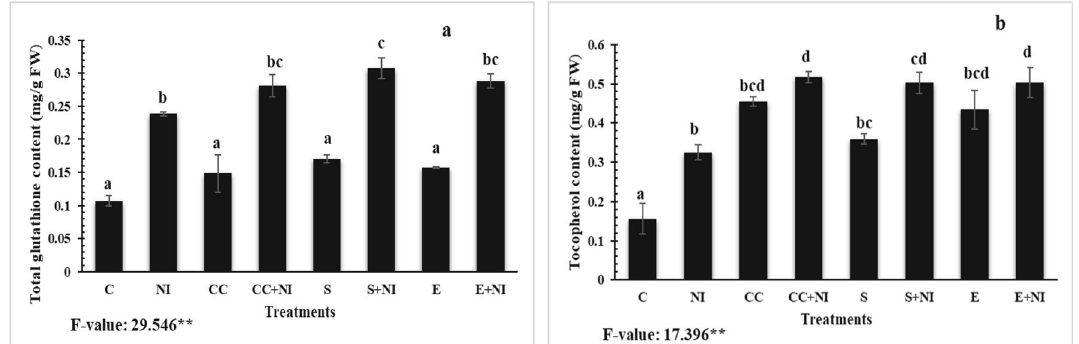
Figure 5. ( a-b ) Levels of non-enzymatic antioxidants ( a ) Total glutathione content; ( b ) Tocopherol content in M. incognita inoculated 60 days old tomato plants treated with S. hydrogenans strain DH-16 in the form of culture cells (CC), supernatant (S) and crude extract (E). Different treatments are represented as C (control), NI (nematode inoculated), CC (culture cells), CC + NI (culture cells + nematode inoculated), S (supernatant), S + NI (supernatant + nematode inoculated), E (crude extract), E + NI (crude extract + nematode inoculated). Results are given in mean ± standard error and F-value ** indicates significance at p ≤ 0.01 as per Tukey’s test. Different letters a, b, c, d represent significant difference among treatments and same letters represent no significant difference.